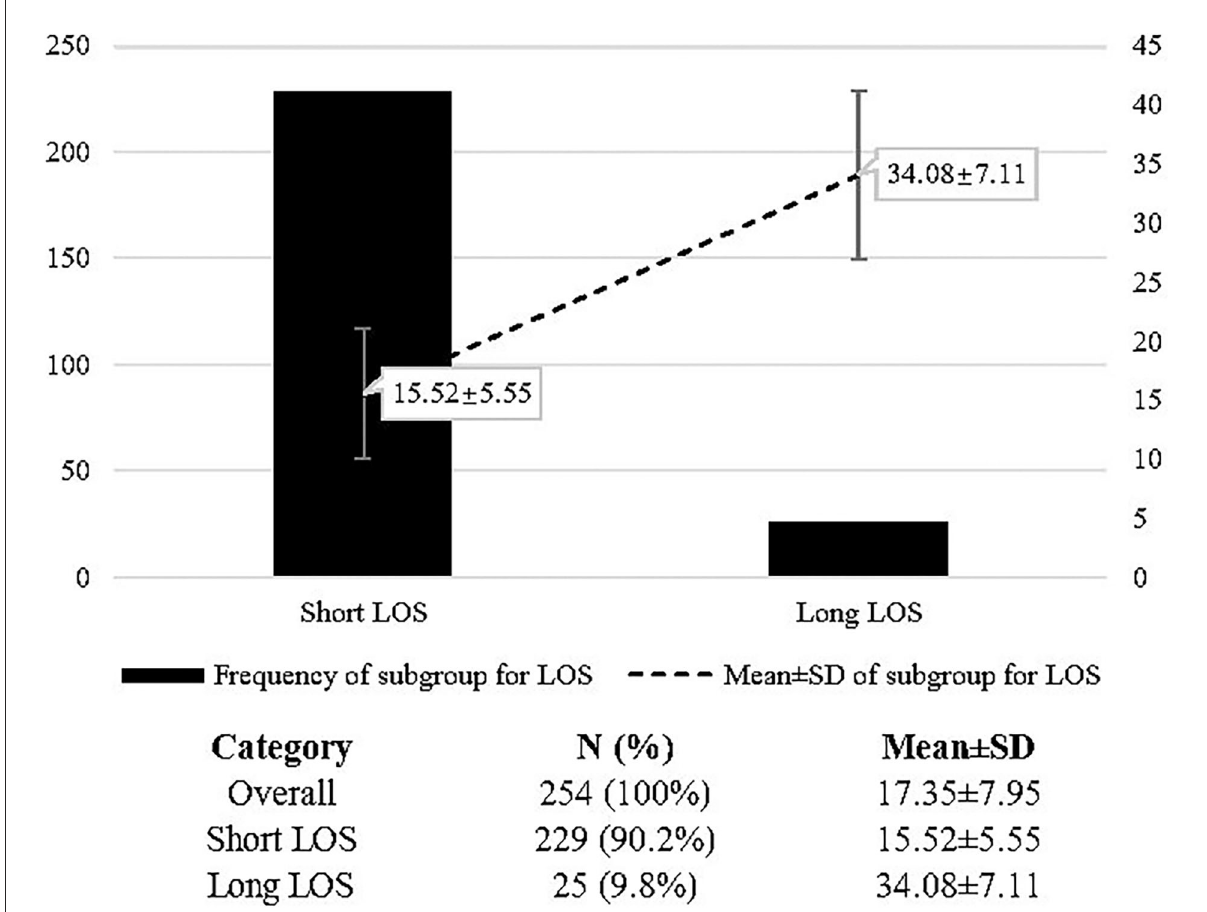
FIGURE1 Frequency and mean value of the length of stay (LOS) for the